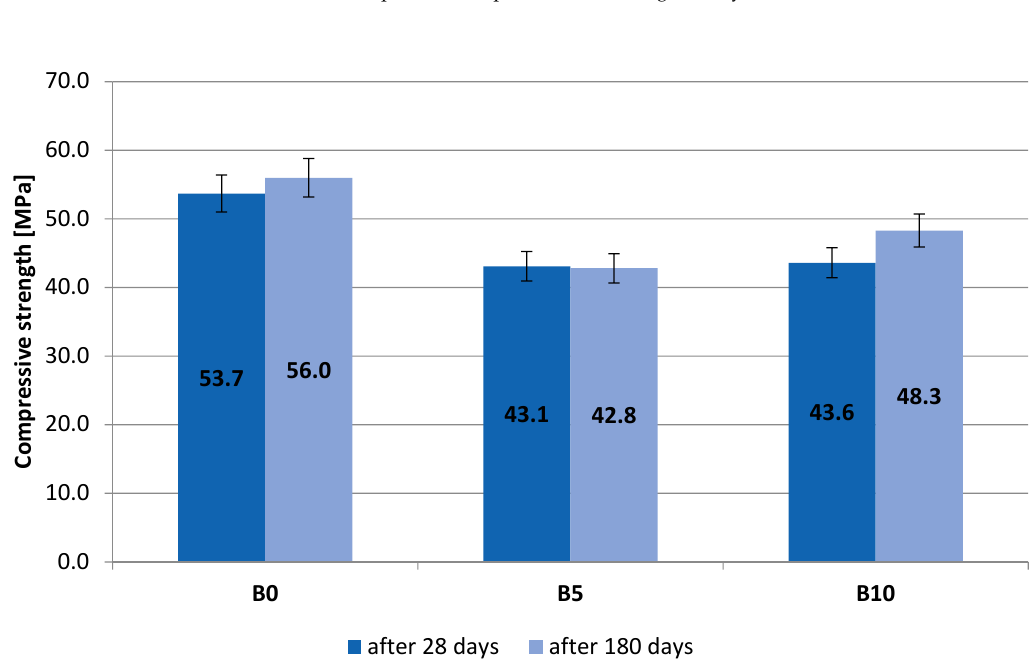
Figure 3. Results of compressive strength testing.